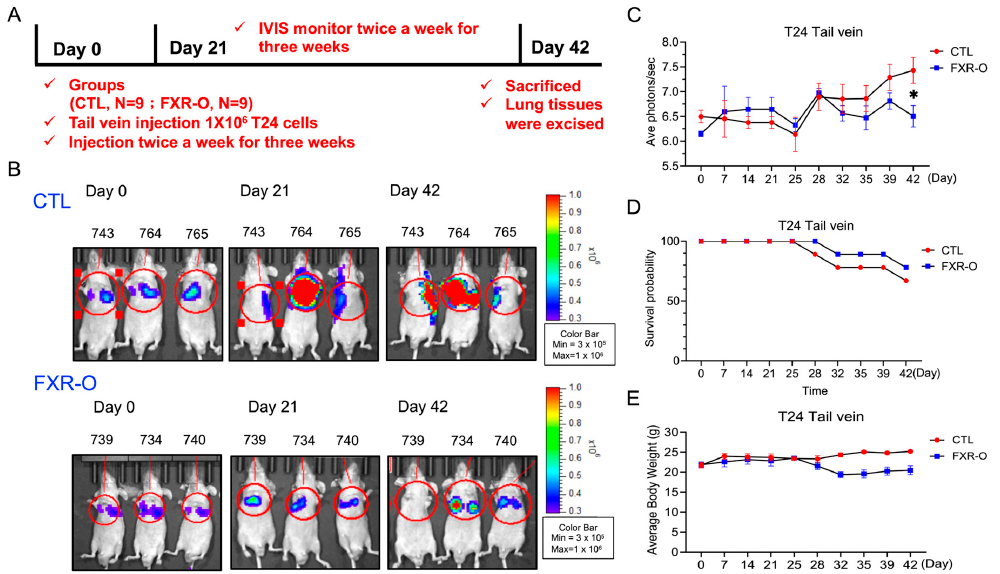
Figure 4. The effect of FXR overexpression on lung metastasis in a xenograft mouse model. ( A ) Ex- perimental timeline. ( B ) The effects of control and FXR-O on the size and growth of tumors were observed using bioluminescent imaging with an in vivo imaging system (IVIS). ( C ) The luminescence intensity of photons emitted from each tumor was quantified (Log). ( D ) The animal survival rate was observed over the 42-day experimental period shown by a Kaplan-Meier survival curves. ( E ) Body weights were measured during the experimental period. * p < 0.05 compared to the control group.